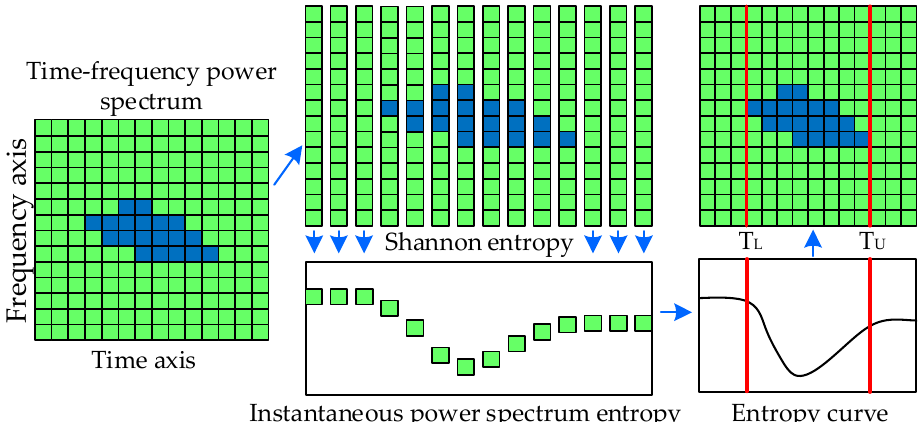
Figure 2. The schematic diagram of proposed IPSE.